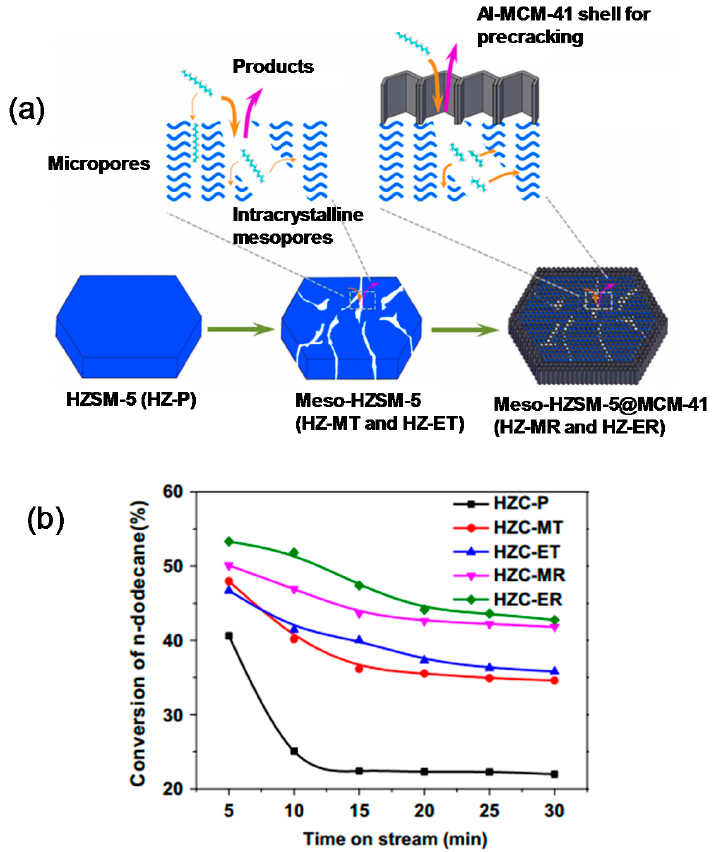
Figure 10. Desilication of the HZSM ‐ 5 (HZ ‐ P) with tetramethyl ‐ ammonium hydroxide (TMAOH) and tetraethyl ‐ ammonium hydroxide (TEAOH) (denoted as HZ ‐ MT and HZ ‐ ET respectively) and